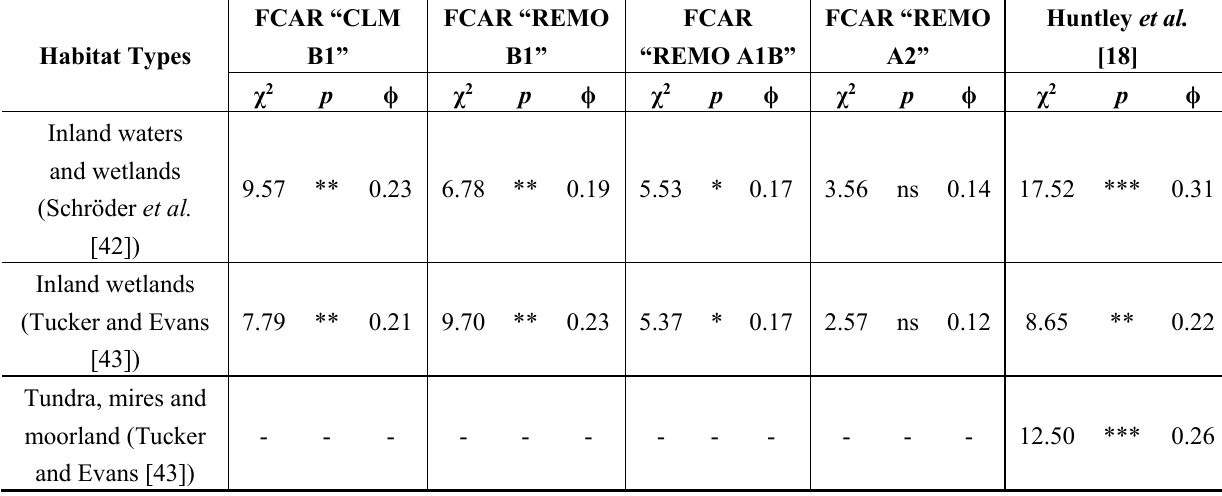
Table 5. Significant positive associations between species classified as “potential leavers” and habitat types. All current species of the LHR are taken into account ( n = 184, df = 1). Habitat